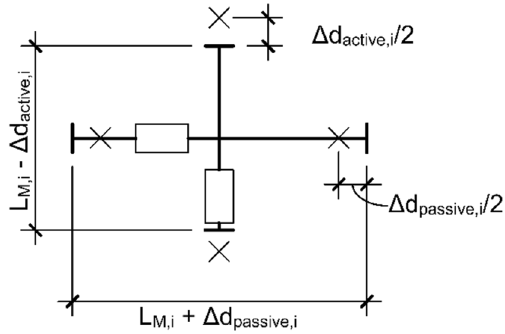
Fig. 2 Measuring zone as shown in Fig. 1a, b after deformation for the diaphragm shear simulation and diagonal compression simu- lation. The x-marks illustrate the position of the measuring points before